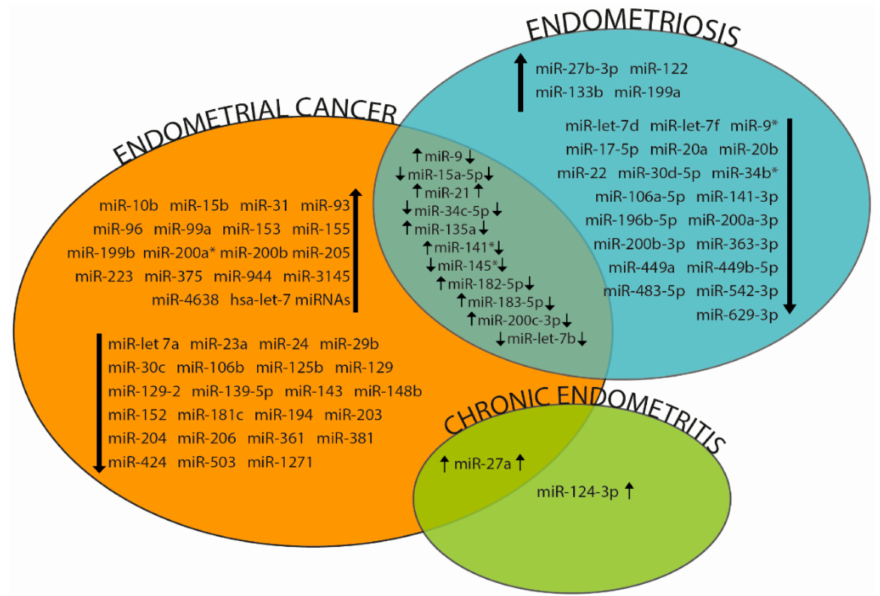
Figure 3. Representative miRNAs involved in endometrial